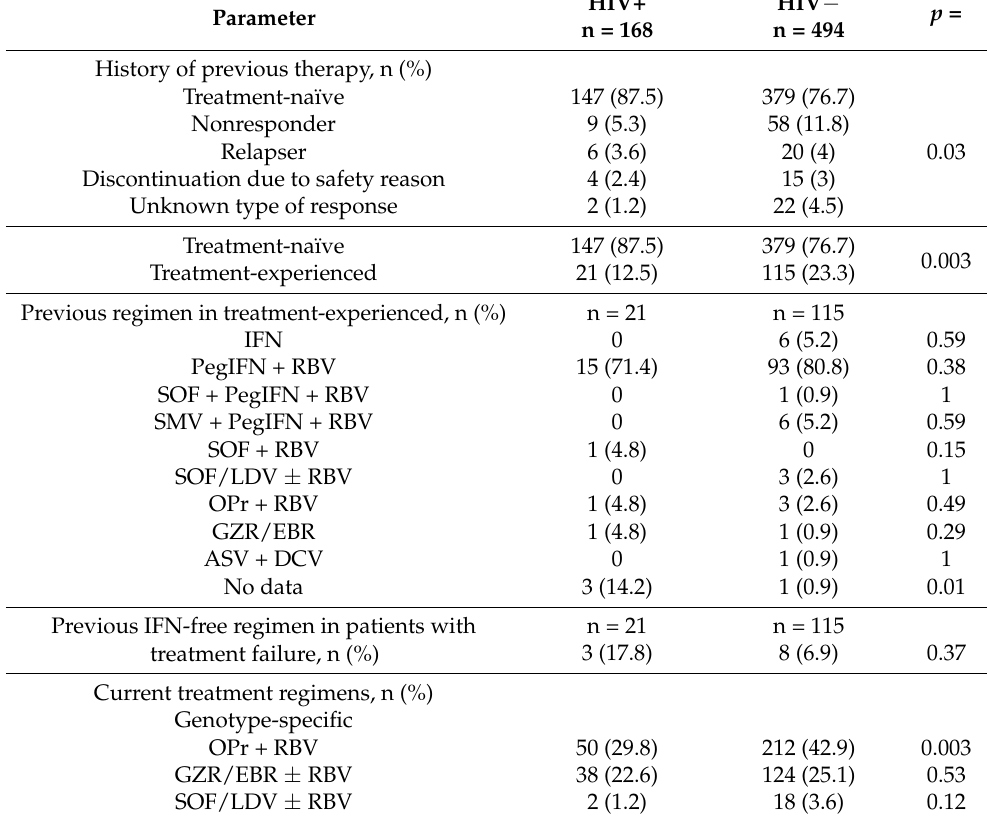
Table 3. Comparison of characteristics in GT4-infected patients depending on the HIV